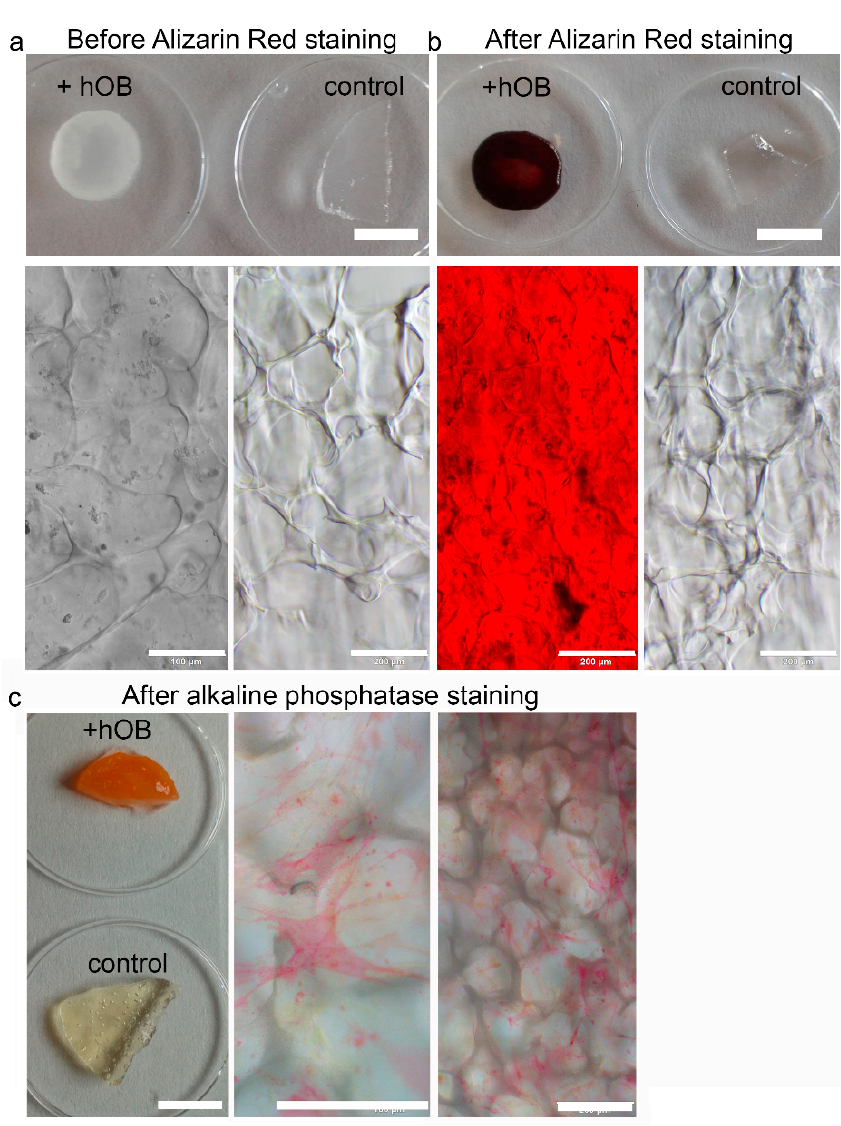
Figure 1. Characterization of the cryogel bone construct. Primary human osteoblasts (hOBs) were cultured for five weeks within the cryogel (including three weeks with mineralization medium). ( a , b ) Plate view (upper) and microscopic view (lower) of the staining. ( a ) Microscopic pictures show hOBs within the cryogel before the staining, ( b ) red positive Alizarin Red in cryogels with hOBs and an empty cryogel as a negative control. The empty cryogel completely leached out and no interference with the cryogel material occurred. For alkaline phosphatase (ALP) staining, hOBs were fixed after five weeks of culture in the cryogel. ( c ) Positive ALP staining indicates osteoblast functionality even after five weeks and formation of bone matrix. Furthermore, the macroscopic image demonstrates no interference of the cryogel with the staining solution. (macroscopic scale bar = 5 mm; microscopic scale bar = 200 µm).